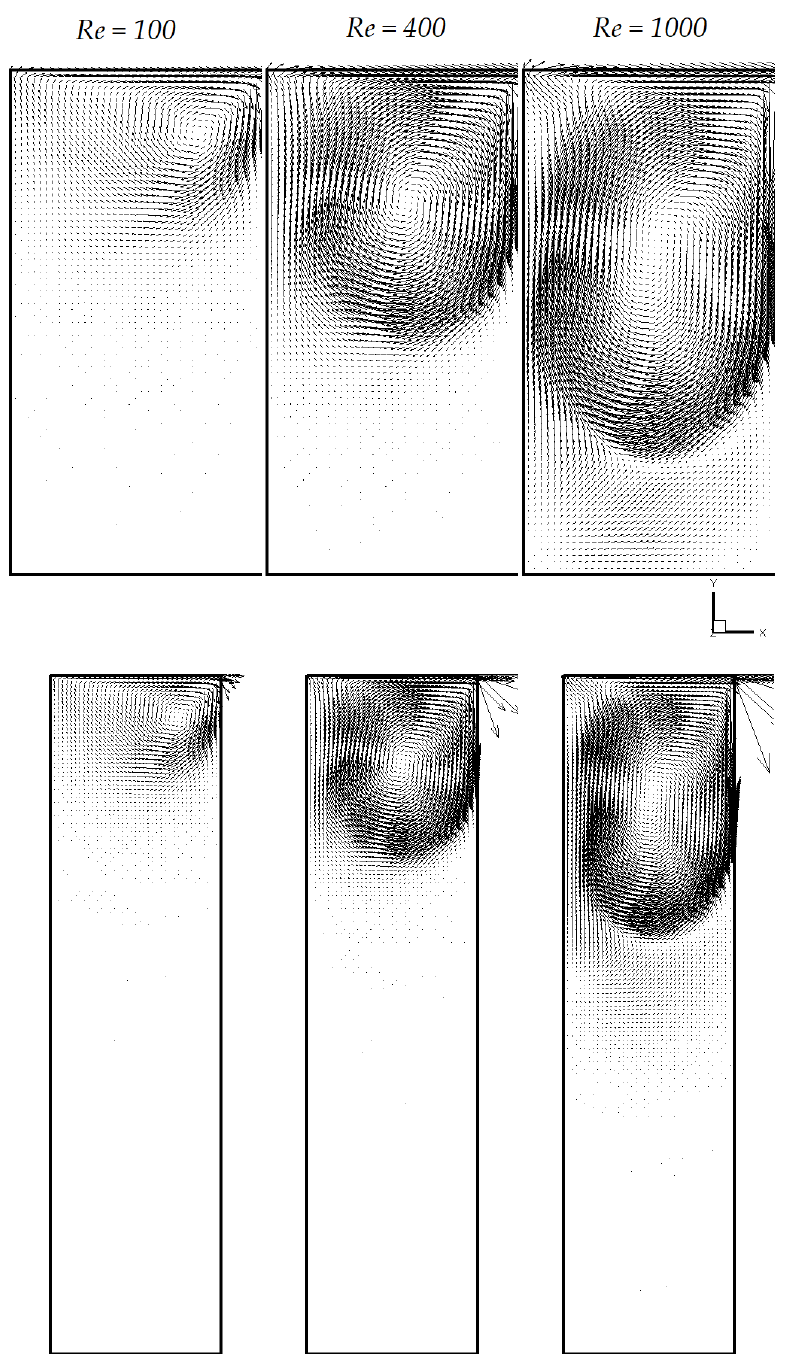
Figure 11. Velocity vector in central x – y plane of Ω for deeper cavities ( δ = 2, 4) as well as different Reynolds number. The non-Newtonian parameter n is equal to